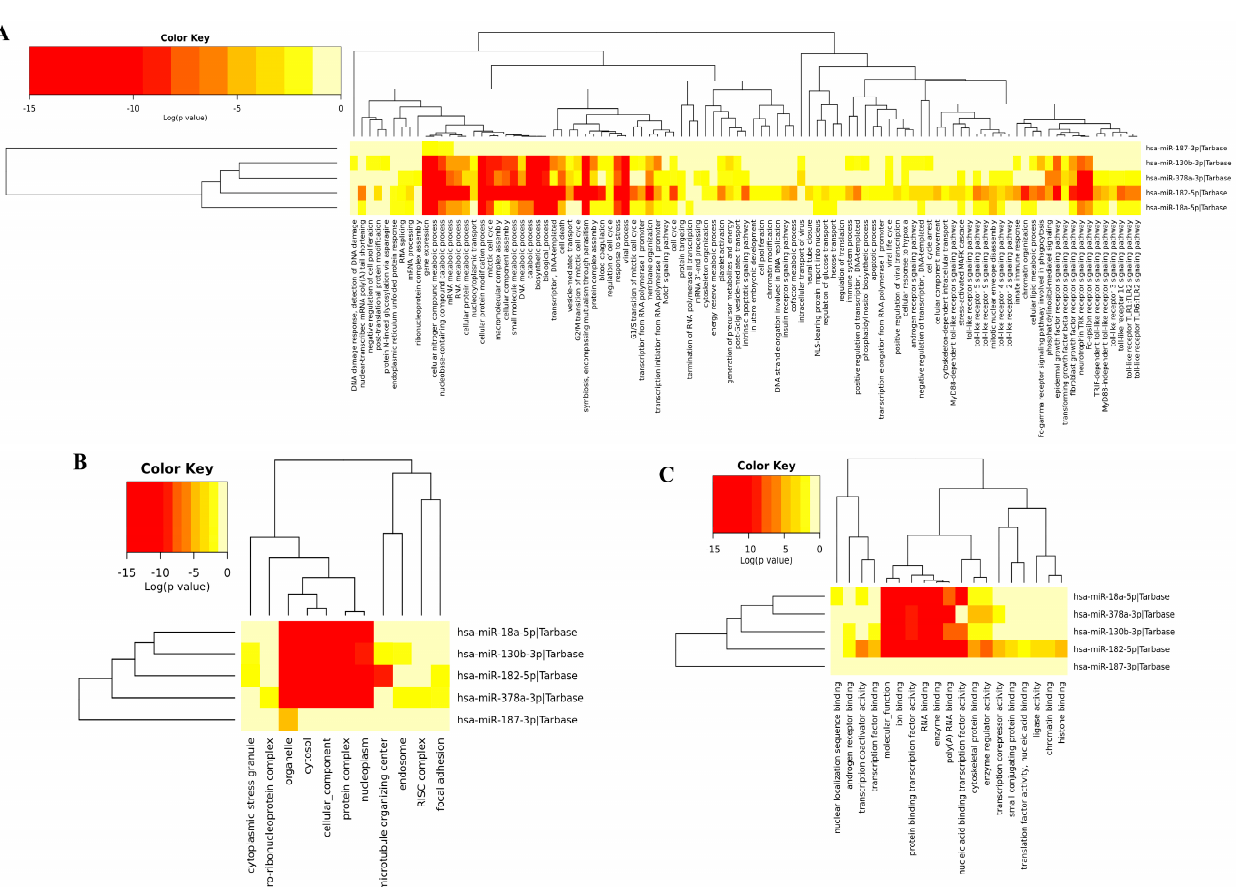
Figure 5. Gene ontology of downregulated miRNAs. (A) Biological processes. ( B) Cellular compo- nents. ( C ) Molecular functions.